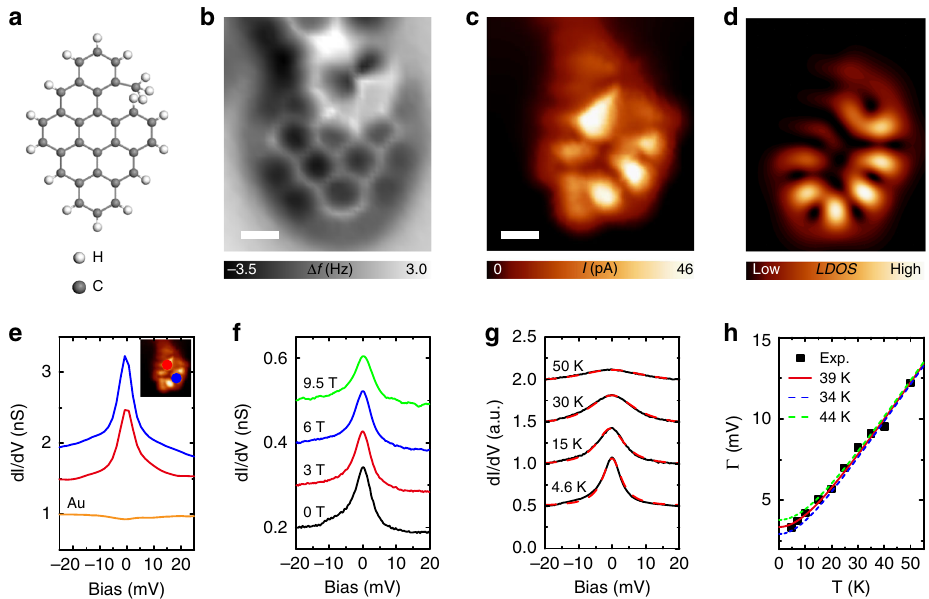
Fig. 2 Detecting the net spin in a bipartite nanographene monomer via Kondo resonance. a Chemical structure of a rhombic bipartite nanographene. b Nc-AFM frequency shift image (Resonant frequency: 29 KHz, Oscillation amplitude: 160 pm) of the nanographene in a . The methyl group is imaged as a bright protrusion due to strong Pauli repulsion. c – d Constant-height current image (Bias voltage: 1 mV) and simulated LDOS map. e dI/dV spectra taken on the two locations marked on the inset current image. A sharp zero-energy peak is resolved due to the screening of the net spin of S = 1/2 in nanographene by Au(111) surface electrons. f Out-of-plane magnetic fi eld dependence of the Kondo resonance. All d I /d V spectra were taken at the same position. g Temperature dependence of the Kondo resonance. All d I /d V spectra were taken at the same position. The dotted lines are simulated curves using a Frota function. h The full peak width at half maximum as a function of temperature. A Kondo temperature of 39 K is obtained. Scale bars: 0.3